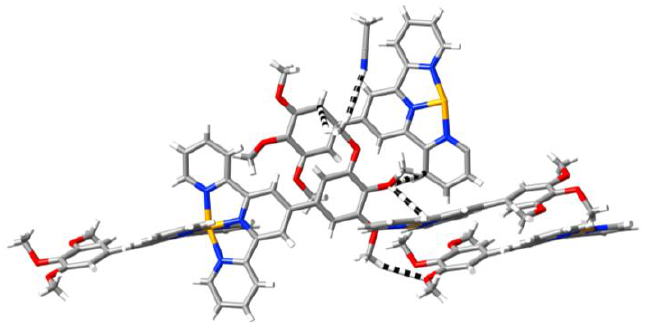
Figure 4. Partial representation of the interactions of methoxy groups on one terminus of a cation within the lattice of [Fe( L1 ) other cations containing groups in interaction with those of the first are shown. The contacts indicated by the black and white dashed lines involve CH…O, CH…N, CH…π and O…π